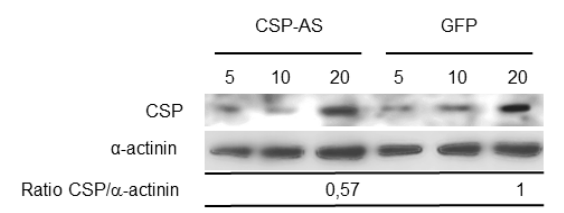
FIGURE 4: Quantification of CSP expression in modified Enta- moeba histolytica trophozoites. Five, ten and twenty µg of pro- tein from crude trophozoite extracts were loaded. CSP (140 kDa) and actinin (70 kDa) were revealed with specific antibodies. A decrease in CSP abundance was observed in trophozoites ex- pressing the CSP-AS construct. Amounts of CSP and actinin in 20 µg of crude extract were quantified using AlphaEaseFC software. Levels of CSP were normalized against the amount of α-actinin. The relative abundance of CSP was 57% lower in CSP-AS tropho- zoites than in WT and GFP trophozoites (P = 0.04). Data are rep- resentative of three independent